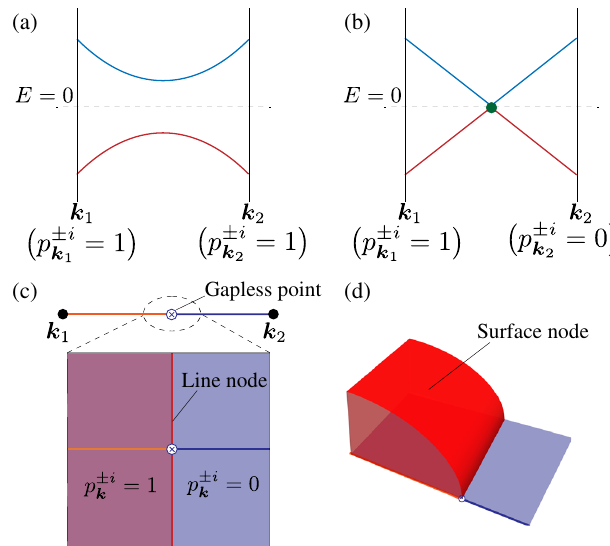
FIG. 2. Illustration of diagnosis based on compatibility con- ditions. (a),(b) Bogoliubov quasiparticle spectrum along the line connecting two momenta k 1 and k 2 . The spectrum satisfies the compatibility conditions on the line in (a), while it does not in (b). (c) Two divisions of the line connecting k 1 and k 2 and a nodal line in a plane containing the line. Here, the red shaded region and others have different values of the topological invariants, whose boundary results in a nodal line. (d) Surface node. When there are compatibility conditions between the plane and its three-dimen- sional neighborhood, the regions in (c) are extended out of the plane, and the boundary surface is the surface node.